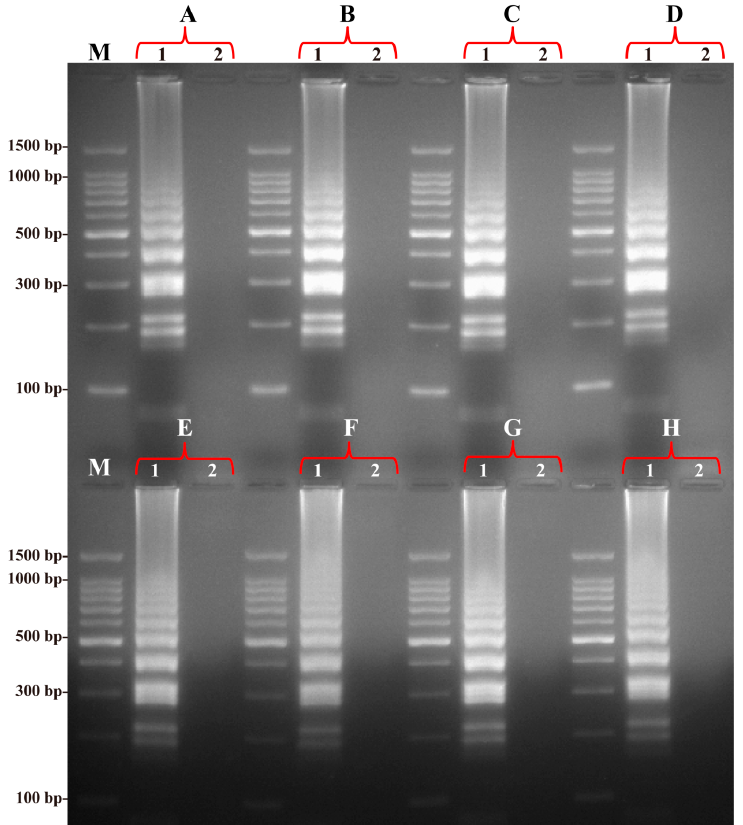
Figure 3. Products of the LAMP monitored using 2.5% agarose gel electrophoresis. The products ( A – H ) of the LAMP from different reaction temperature (60–67 °C) were monitored by 2.5% agarose gel electrophoresis after staining with ethidium bromide. Lane M, DL 100 ‐ bp DNA marker; Lane 1, positive LAMP products; Lane 2, negative control (no DNA).